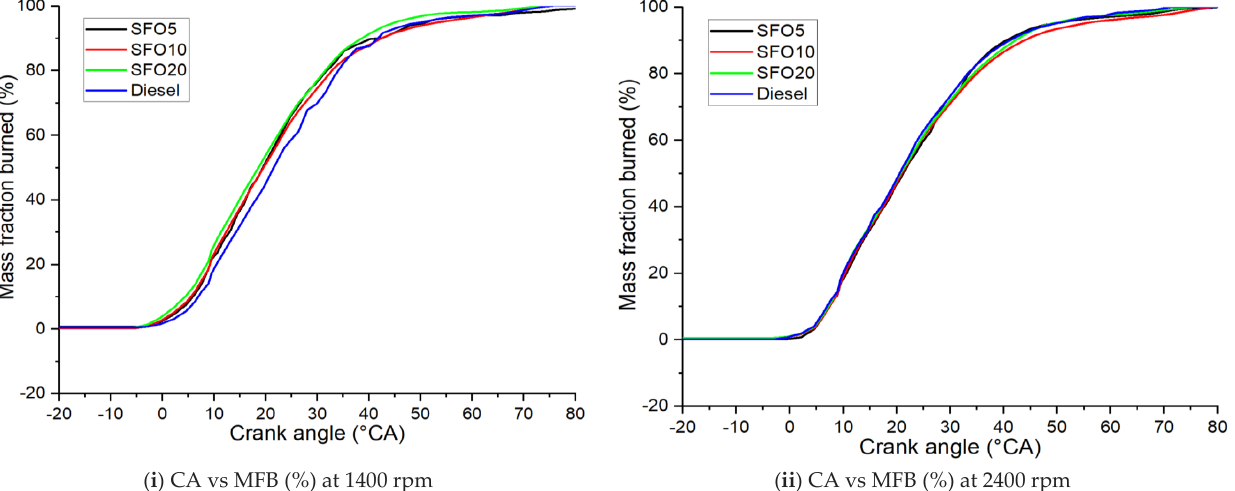
Figure 12. The variations in mass fraction burned (%) for SFO blends and diesel under 100% engine load at speeds of ( i ) 1400 rpm and ( ii ) 2400 rpm.